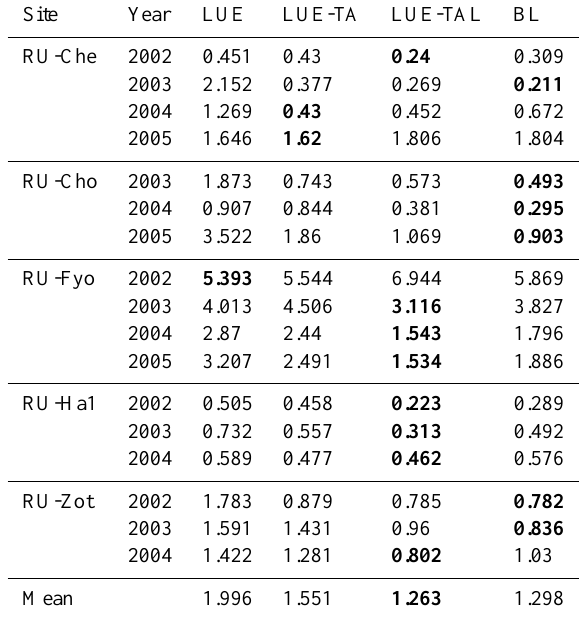
Table 7. Cross-validation results (MSE) from the LUE, LUE-TA, LUE-TAL and BL models for all site years, and mean results for each model. Bold indicates lowest recorded MSE values per site year and